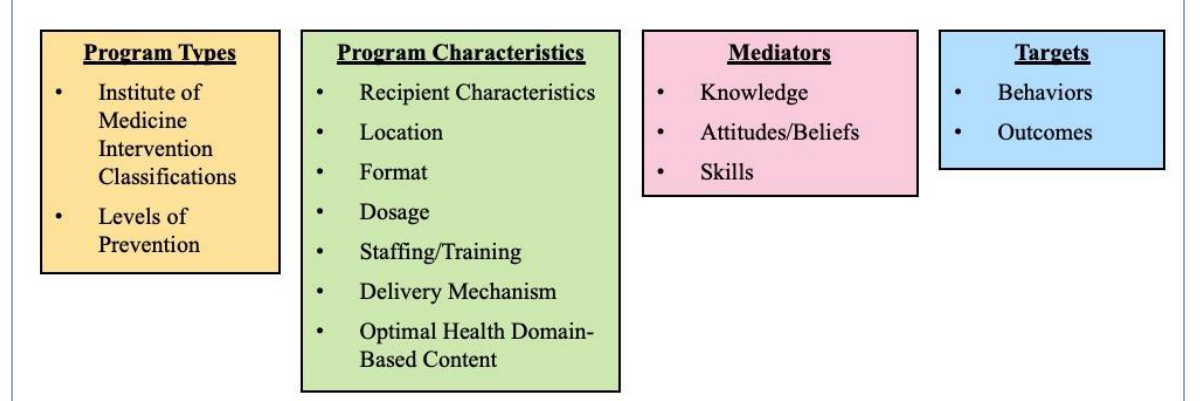
Figure 1. Organizing Framework Based on Committee Consensus Regarding the Features or Components of Programs or Interventions That Have the Potential to Promote Optimal Adolescent